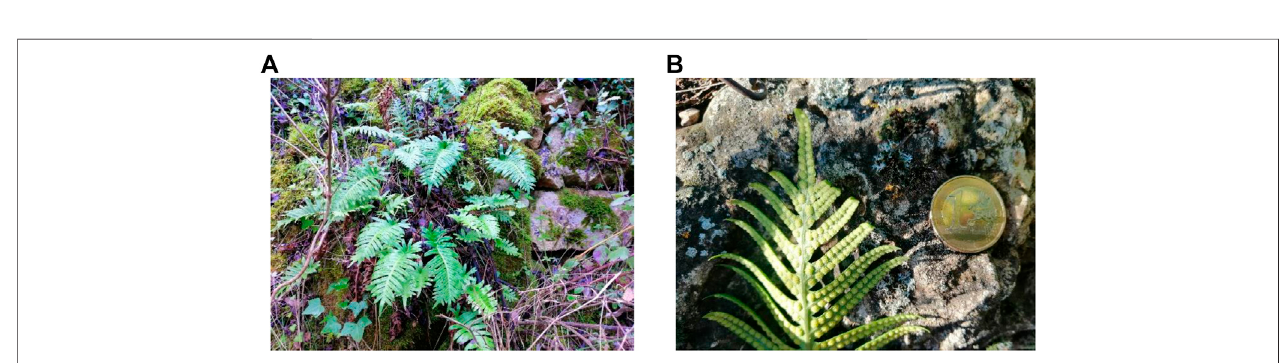
IMAGE 1 | Photography of the face fronds (A) and underside frond (B) of fresh Polypodium vulgare L. ( Polypodiaceae ). Pictures were taken by Adrià Farràs at Prades mountains. The euro coin re fl ects the dimension of the frond (image 1B).